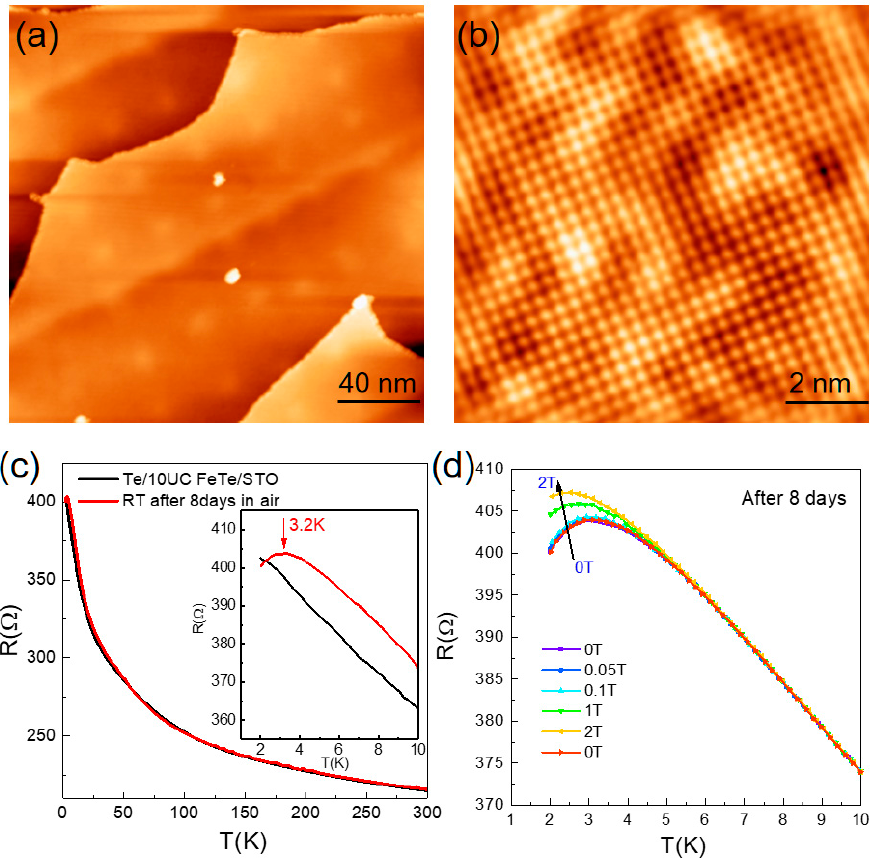
Figure 1. (Color online) ( a ) Surface topography (200 nm × 200 nm) of the 10UC FeTe films on the Nb:STO. Scanning condition: sample bias V s = 3 V, tunneling current I t = 100 pA. ( b ) Typical atomically resolved STM image (10 nm × 10 nm) of 10UC FeTe. Scanning condition: sample bias V s = 0.7 V, tunneling current I t = 200 pA. ( c ) Temperature-dependent resistance ( R-T ) curve of 10UC FeTe thin film on HR-STO before and after exposure to air for 8 days. Inset: R-T curve under low temperature, showing turn-down behavior after exposure to air. ( d ) Temperature-dependent resistance of 10UC FeTe after exposure to air for 8 days under an out-of-plane magnetic field up to 2 T. The turn-down behavior was suppressed under magnetic fields and recovered after magnetic field